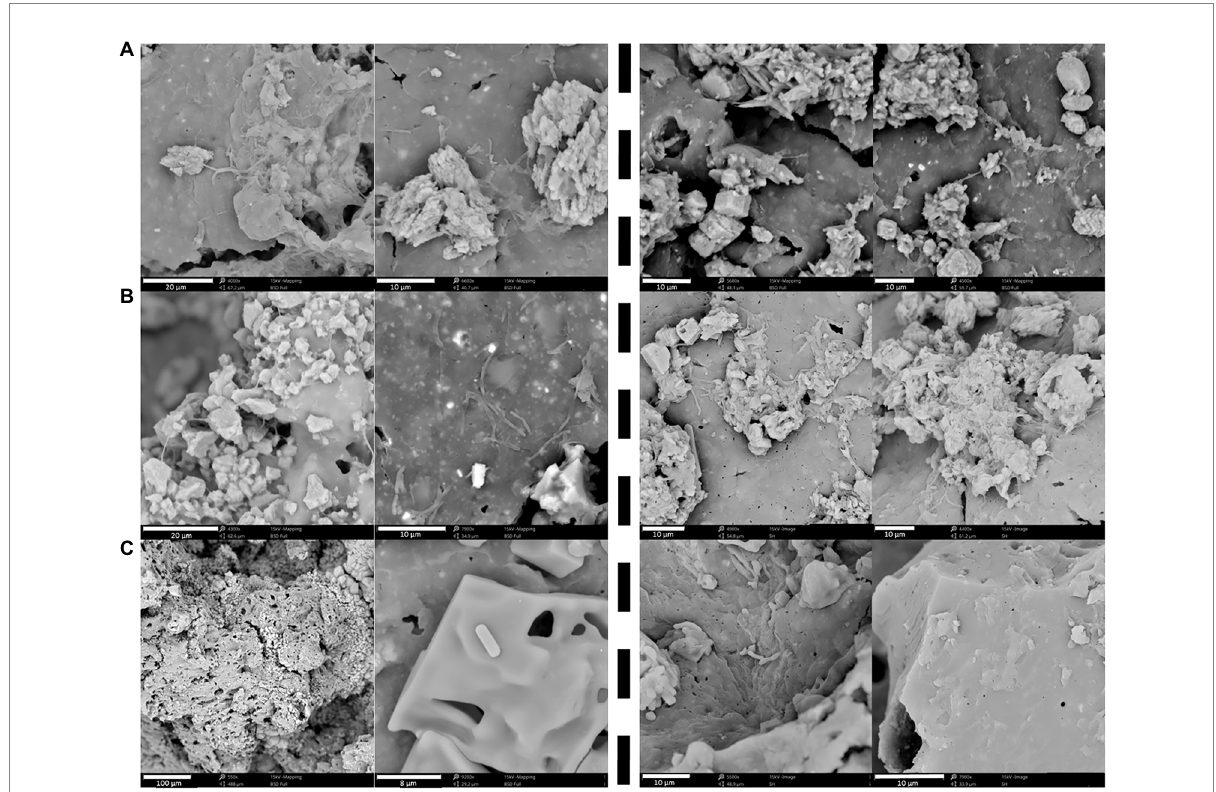
FIGURE 5 Biofilm formation on the Eurobitum cubes visualized with scanning electron microscopy (SEM) of thermally aged non-radioactive Eurobitum inoculated with Boom Clay Borehole water (left of the dotted line) or inoculated with Harpur Hill sediment (right of the dotted line) obtained after 110 days at (A) pH 9; (B) pH 10.5 and (C) pH